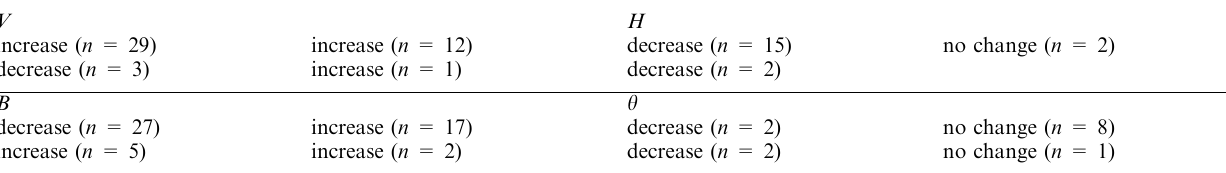
Table 1. Classification of 32 GOES 5 events during 2100–0100 LT, n = no. of events